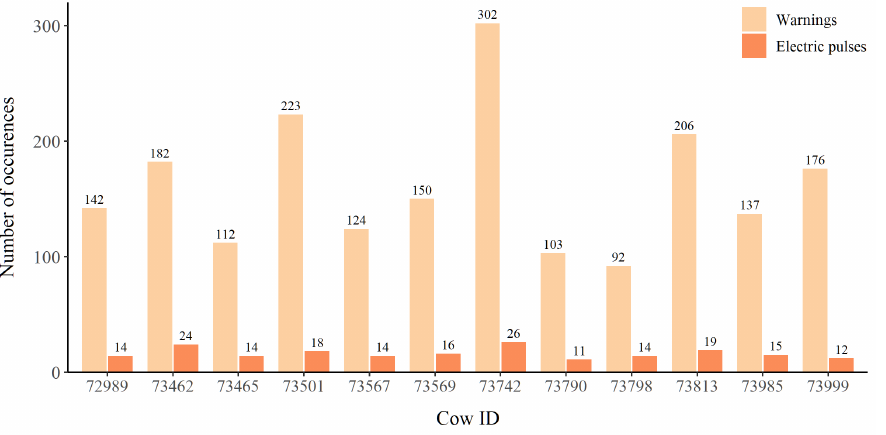
Figure 2. The number of auditory warnings and electric impulses that each individual received throughout the 139-day experiment.